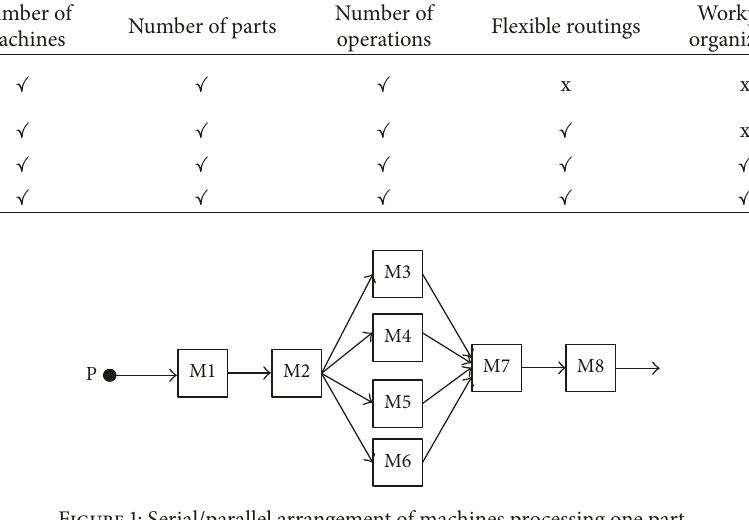
Figure 1: Serial/parallel arrangement of machines processing one part.